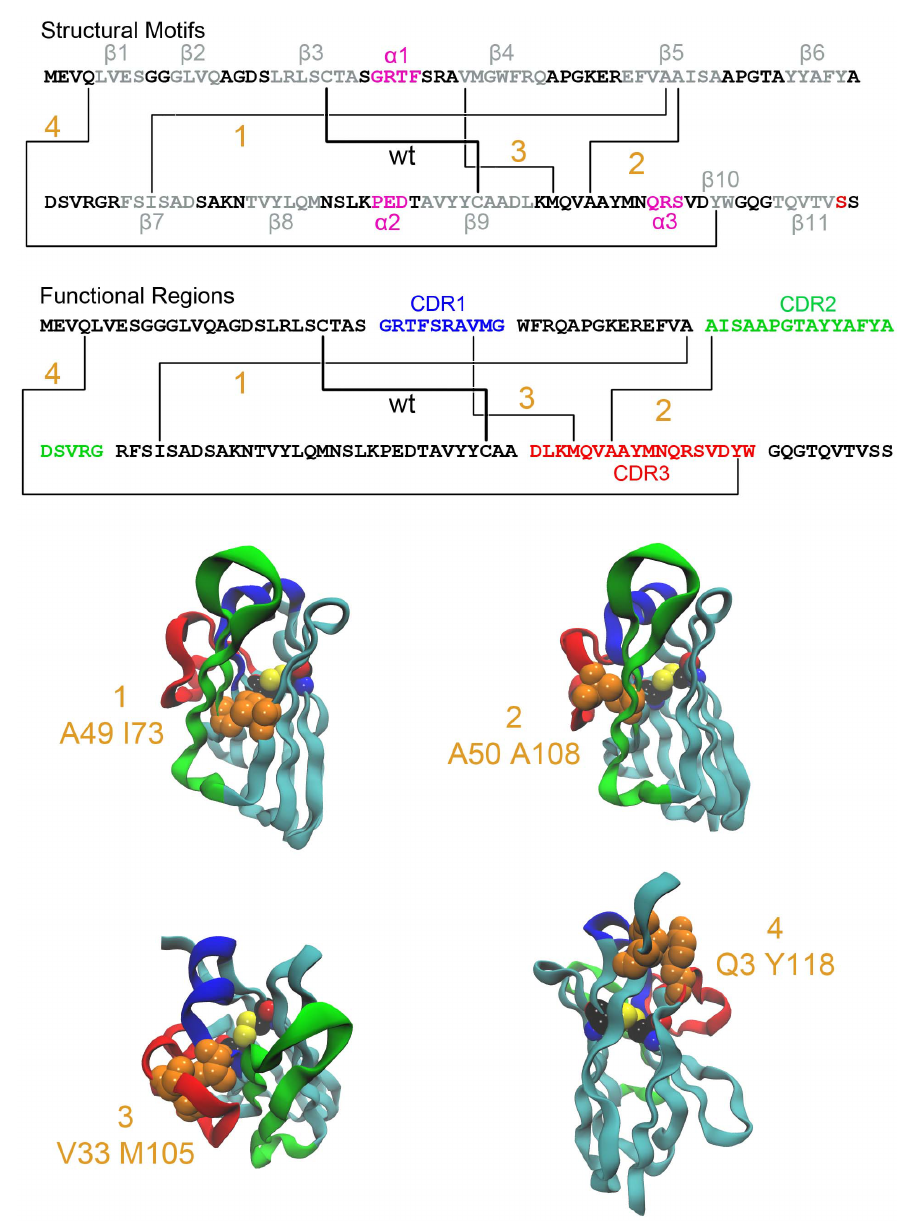
Fig. 1. Locations of the disulfide bonds added to sdAb A3 in Constructs 1 through 4. The amino acid sequence of sdAb A3 is given with lines connecting the residues which are changed to cysteine in the constructs as shown. The three dimensional location of each new disulfide bond is shown as an orange- colored space-filling representation of the amino acid pair in the crystal structure of sdAb A3. The CDRs are color coded blue, green, and red, respectively. The native disulfide bond is shown as a standard color space- filling representation.